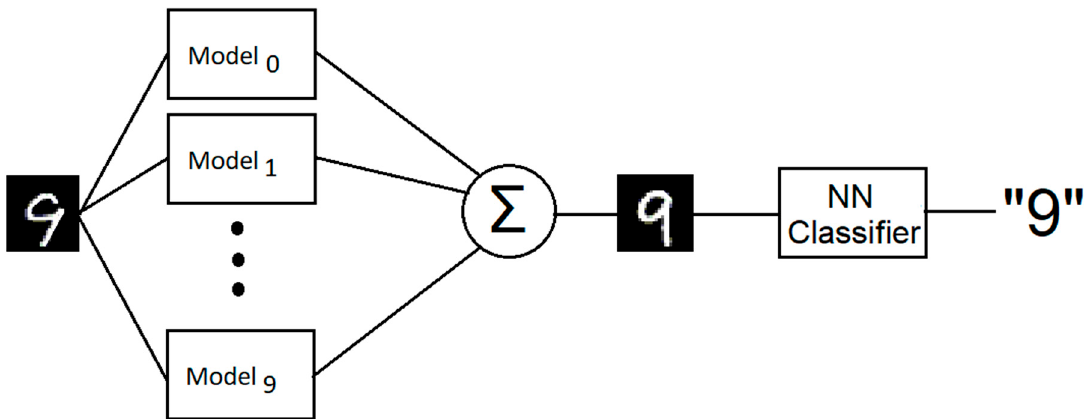
Figure 3. High-level view of the architecture. There are ten models/generators; each specializes in reconstructing a specific digit. The output of each generator is either the holistic representation of the digit it was trained for or the blank image. A composite image is constructed by summing the output of all models. The composite image is fed to a neural network for classification.